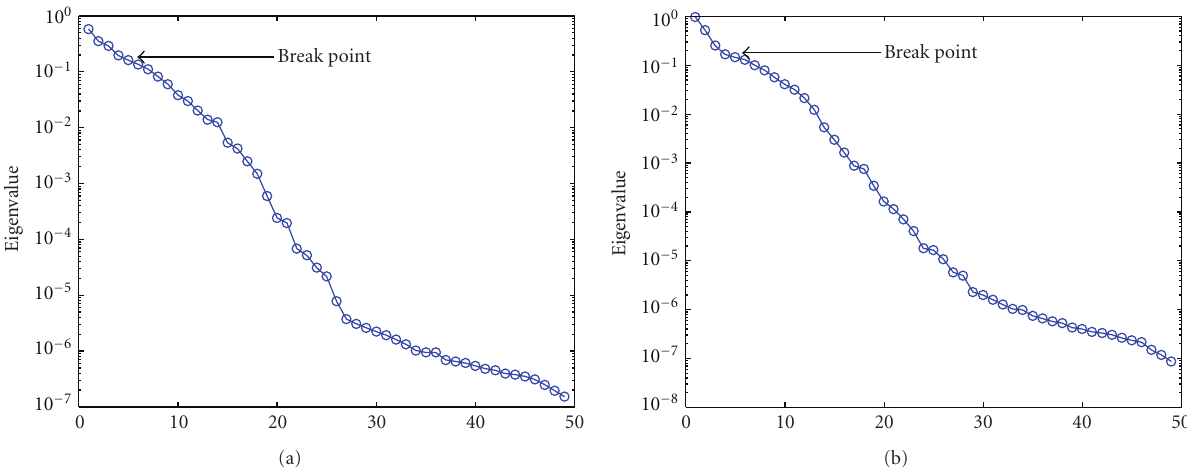
Figure 4: Eigenvalues of the multistatic response matrix of through-wall imaging targets: (a) on the scattered data without migration; (b) on the scattered data after